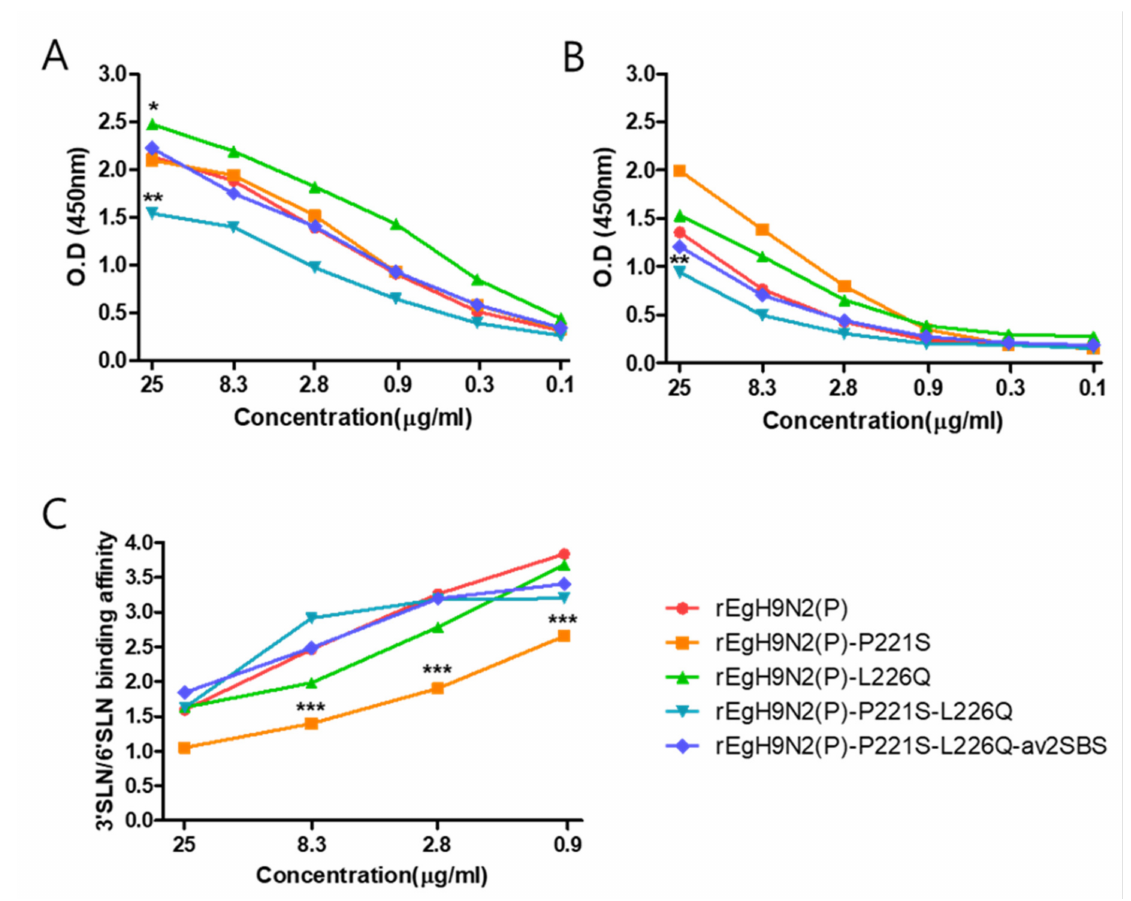
Figure 4. Most mutations decreasing avian receptor affinity have no effect on the ratio of avian to mammalian receptor affinities. Each virus was diluted to the same concentration (2 6 HAU) with neuraminidase inhibitor, blocking buffer was added, and the virus was adsorbed on a 96-well immunoplate. ( A ) Avian receptor analog (3 (cid:48) SLN-PAA) and ( B ) human receptor analog (6 (cid:48) SLN- PAA) three-fold diluents were added and reacted with HRP-conjugated streptavidin after 1 h. HRP was developed by TMB, and the absorbance at 450 nm was measured after the addition of 0.1 M sulfuric acid. ( C ) The relative binding affinity was calculated by dividing the 3 (cid:48) SLN binding affinity by the 6 (cid:48) SLN binding affinity, *: rEgH9N2(P)-L226Q had a significantly higher binding affinity to 3 (cid:48) SLN than other viruses, **: rEgH9N2(P)-P221S-L226Q showed significantly lower affinity to 3 (cid:48) SLN than other viruses and to 6 (cid:48) SLN than rEgH9N2(P)-P221S and rEgH9N2(P)-L226Q ( p < 0.05), ***: rEgH9N2(P)-P221S was significantly different from other viruses ( p <